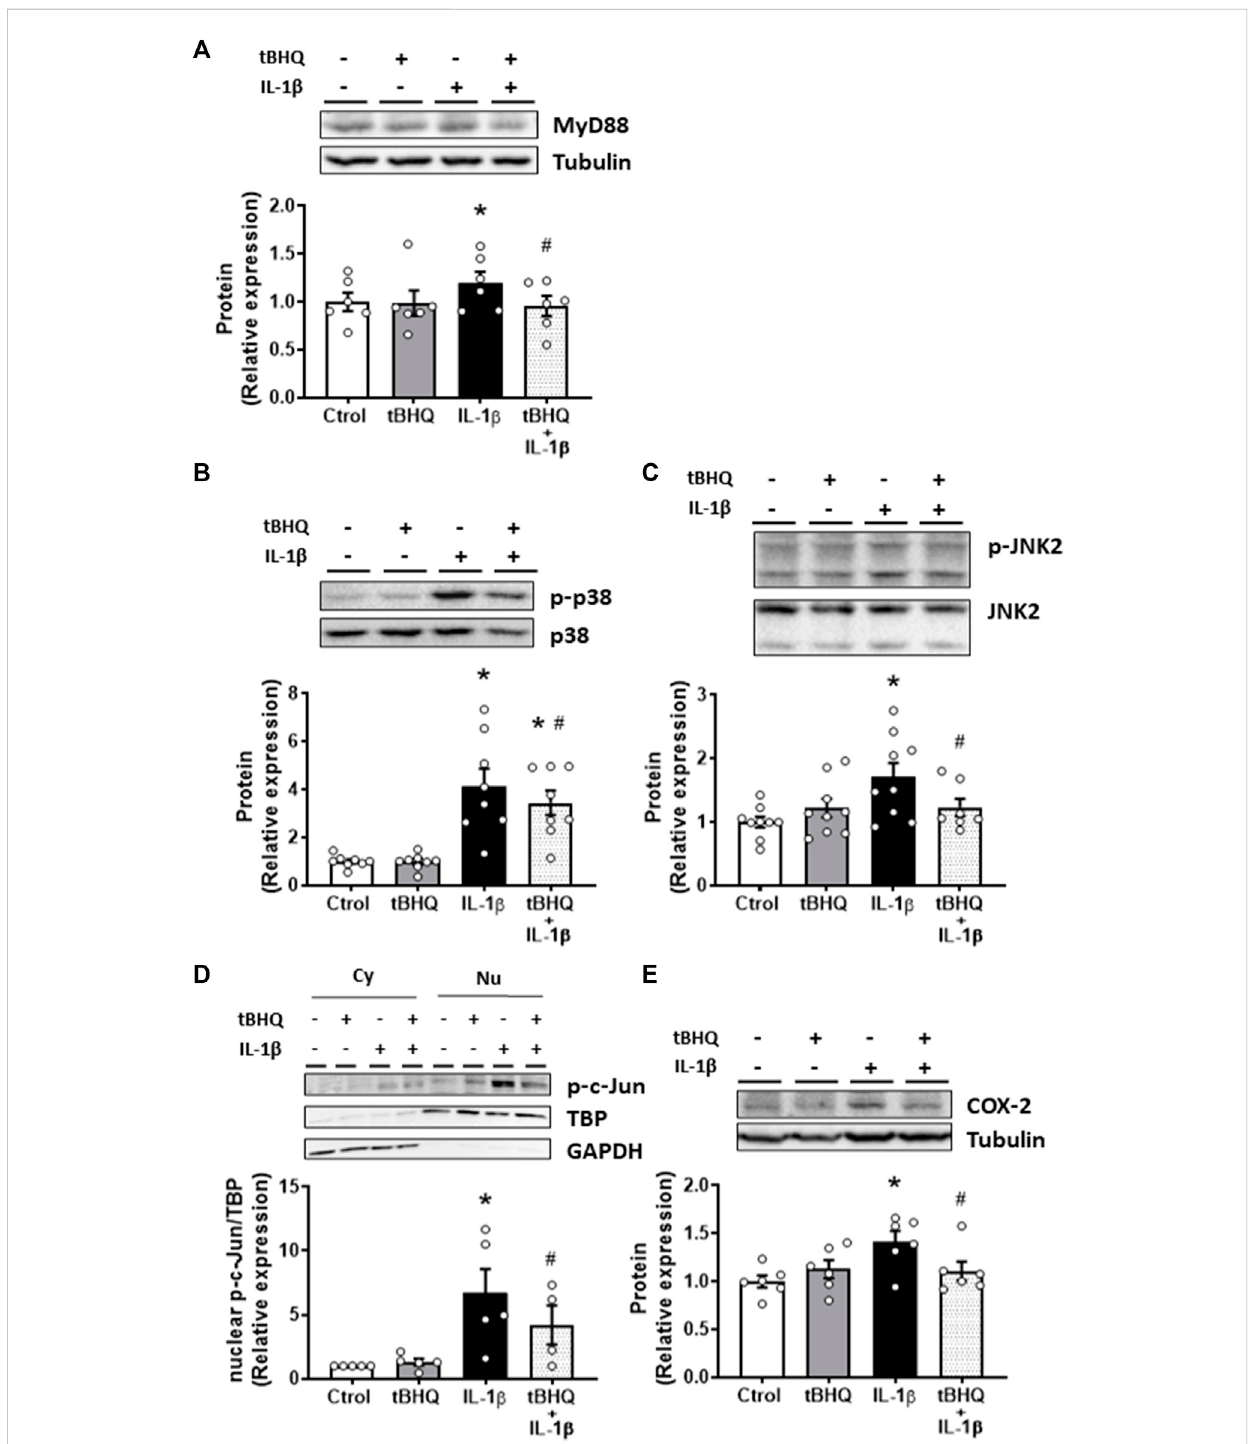
Modulation by Nrf2 activation of IL-1 β -induced-effects on proin fl ammatory markers. Effect of tert-butylhydroquinone (tBHQ, 20 μ M, 24 h), Interleukin-1 β (IL-1 β , 10 ng/mL, 1 h) and tBHQ + IL-1 β on myeloid differentiation factor 88 [MyD88, (A) ], p-p38 (B) , p-JNK2 (C) , nuclear p-c-Jun (D) and cyclooxygenase-2[COX-2, (E) ]proteinexpressioninvascularsmoothmusclecells. Representativeblotsareshowninupperpanels.Arepresentativeblot ofthecytosolic(Cy)andnuclear(Nu)expressionofp-c-Junisalsoshown (D) ;nuclearTATA-bindingprotein(TBP)andcytosolicGAPDHexpressions are also shown to guarantee the successful cellular fractioning * p < 0.05 vs. control; # p < 0.05 vs. IL-1 β by Student ’ s t -test ( n = 5 –